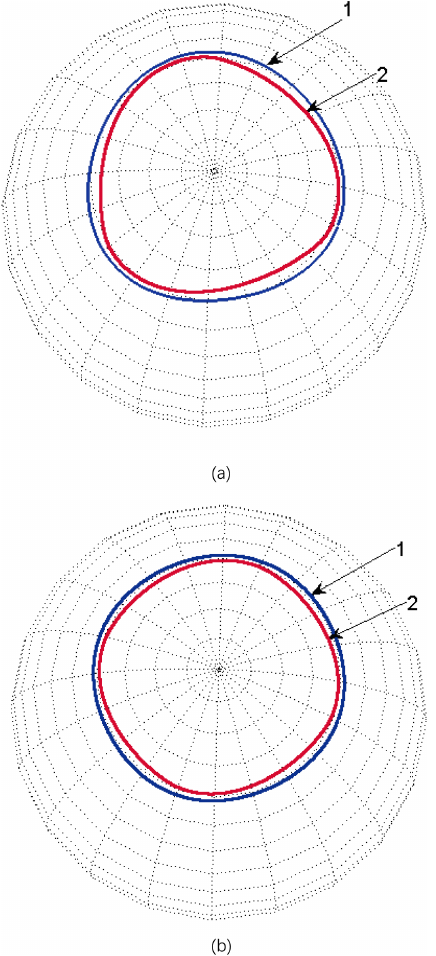
Figure 5. Spherical base curve of tooth profile curve of high order noncircular bevel gear (Small eccentricity). (a) φ = 3 ◦ , λ = 74 ◦ , n = 3. (b) φ = 1 ◦ , λ = 74 ◦ , n = 4. 1 – Pitch curve. 2 – Spherical base curve of right tooth profile.